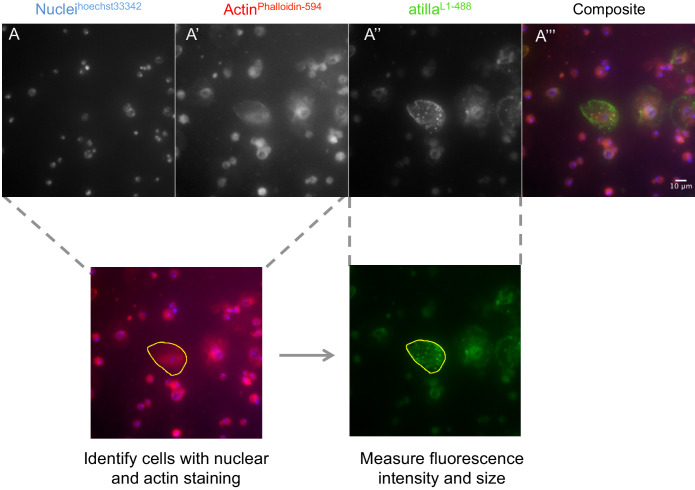
Hemocyte size and atilla staining intensity in circulating hemocytes.Hemocytes were stained for nuclei (A, hoechst 33342), Actin (A’, Phalloidin- Alexa594) and atilla (A’’, L1 antibody + Alexa488). Composite images were created for phallodin and hoechst staining to identify cells with selection tool (yellow line) and fluorescence intensity was measured in L1 staining.